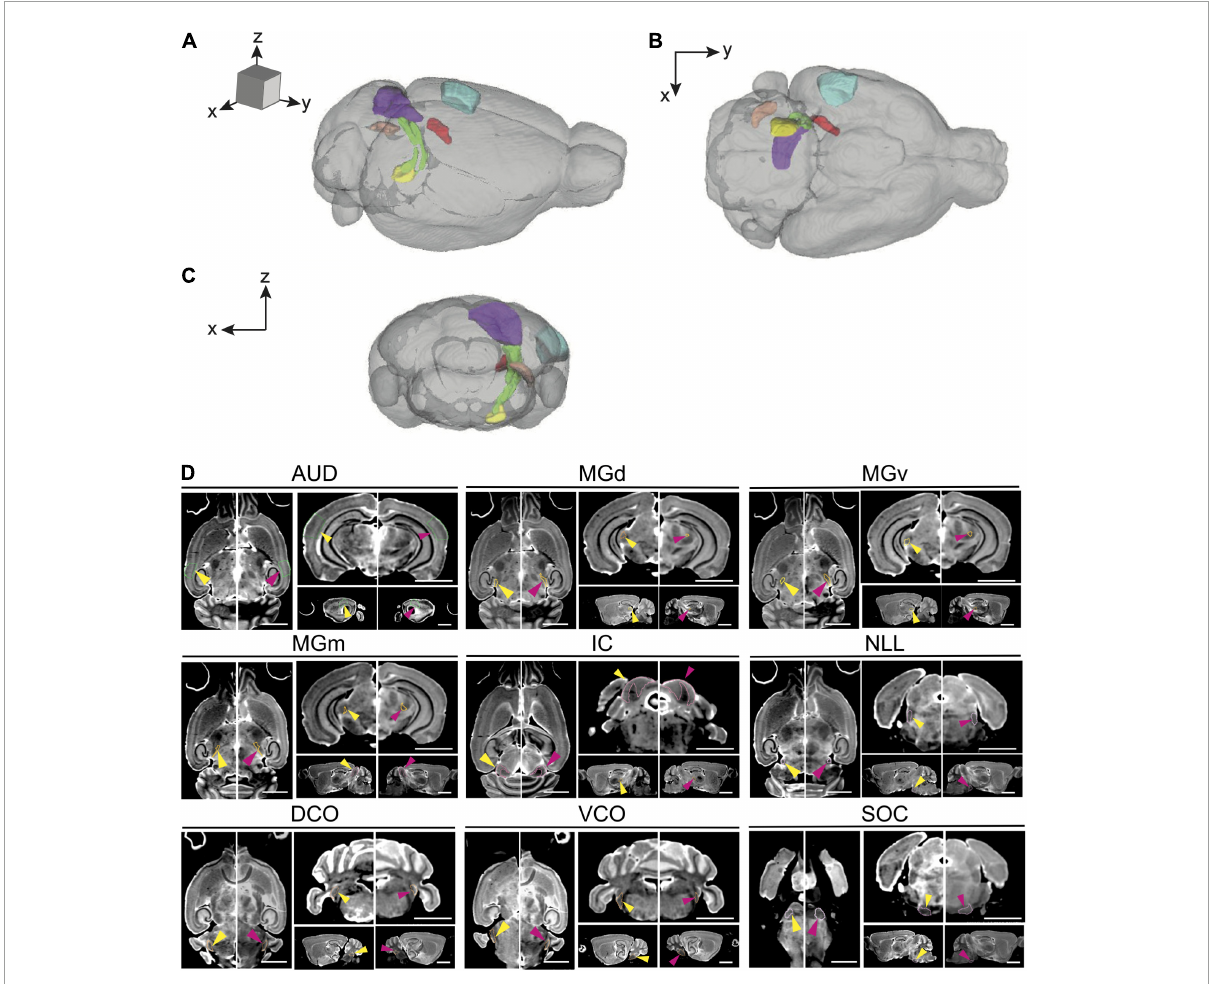
FIGURE1 Magnetic resonance imaging of the auditory pathway. (A–C) 3D volume rendering of mouse auditory brain structures of the average old mouse structure size within the (A) sagittal, (B) axial, and (C) coronal planes. Colored structures represent specific central auditory structures: Blue; auditory cortex, Red; medial geniculate complex (dorsal, ventral and medial), Purple; inferior colliculus and its nucleus, Yellow; superior olivary complex, Orange; dorsal cochlear nucleus, Green; lateral lemniscus. (D) Representative axial, coronal, and sagittal plane magnetic resonance images of all structures in the auditory pathway of a young and an old BXD51 mouse. The images have an arrow aimed at the individual outlined structure. Within each image pair, the left image with a yellow arrow is the young mouse image and the right image with a pink arrow is the old mouse image. Scale bars in all planes is 2.5 mm. AUD, Auditory cortex; MGd, Medial geniculate nucleus, dorsal part; MGv, Medial geniculate nucleus, ventral part; MGm, Medial geniculate nucleus, medial part; IC, Inferior colliculus; LL, Lateral lemniscus; SOC, Superior olivary complex; DCO, Dorsal cochlear nucleus; VCO, Ventral cochlear